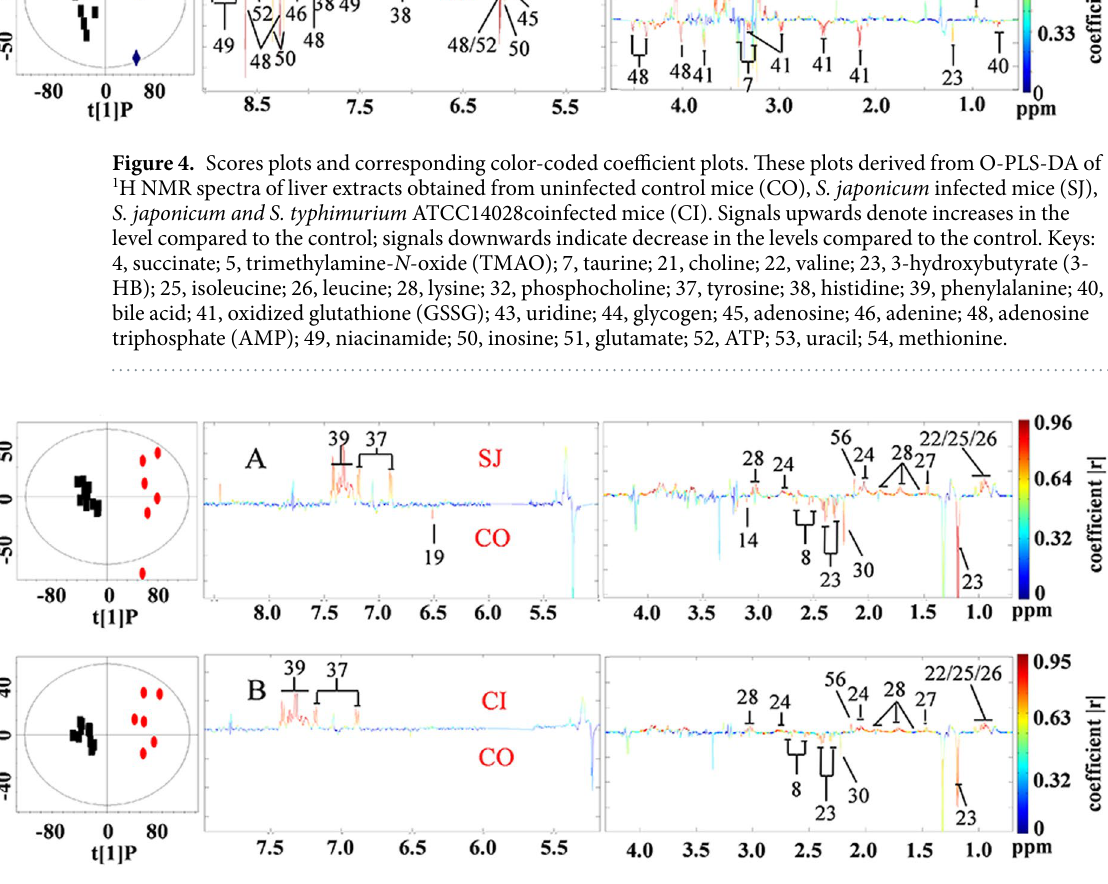
proteinase secreted by the eggs initiates host immune responses and provokes the typical eosinophilic inflam- matory and subsequent granulomatous reaction, and eventually leads to liver fibrosis 19 . This process in normal circumstances is irreversible even with drug treatment since drugs only kill adult worms but cannot remove eggs that have already deposited in tissues. However, our results showed that co-infecting mice with S. typhimurium could potentially reverse the process of schistosomiasis by not only reducing number of adult worms but also reducing the numbers of eggs trapped in liver and intestinal tissues. The complex immune interaction between the two pathogens within the host could play an important role in the observed phenomenon. The early lifecycle of S. japonicum induces the host to develop Th1-polarized cel- lular immunity in response to S. japonicum antigens 43 . After 3 weeks, when paired adult S. japonicum worms begin to lay eggs, egg antigens trigger the host immune response towards Th2-mediated humoral immunity 44 .